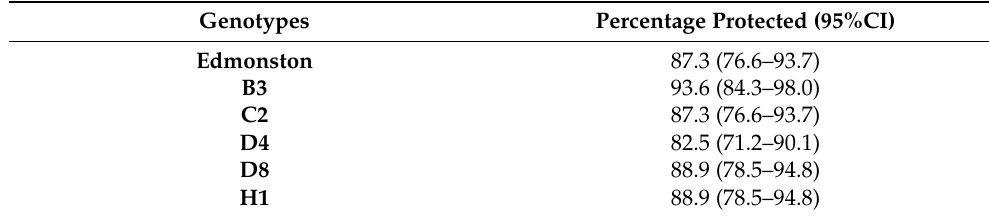
Table 1. Proportion of Sheffield HCWs with neutralising antibody titres greater than the protective threshold against the MeV genotypes